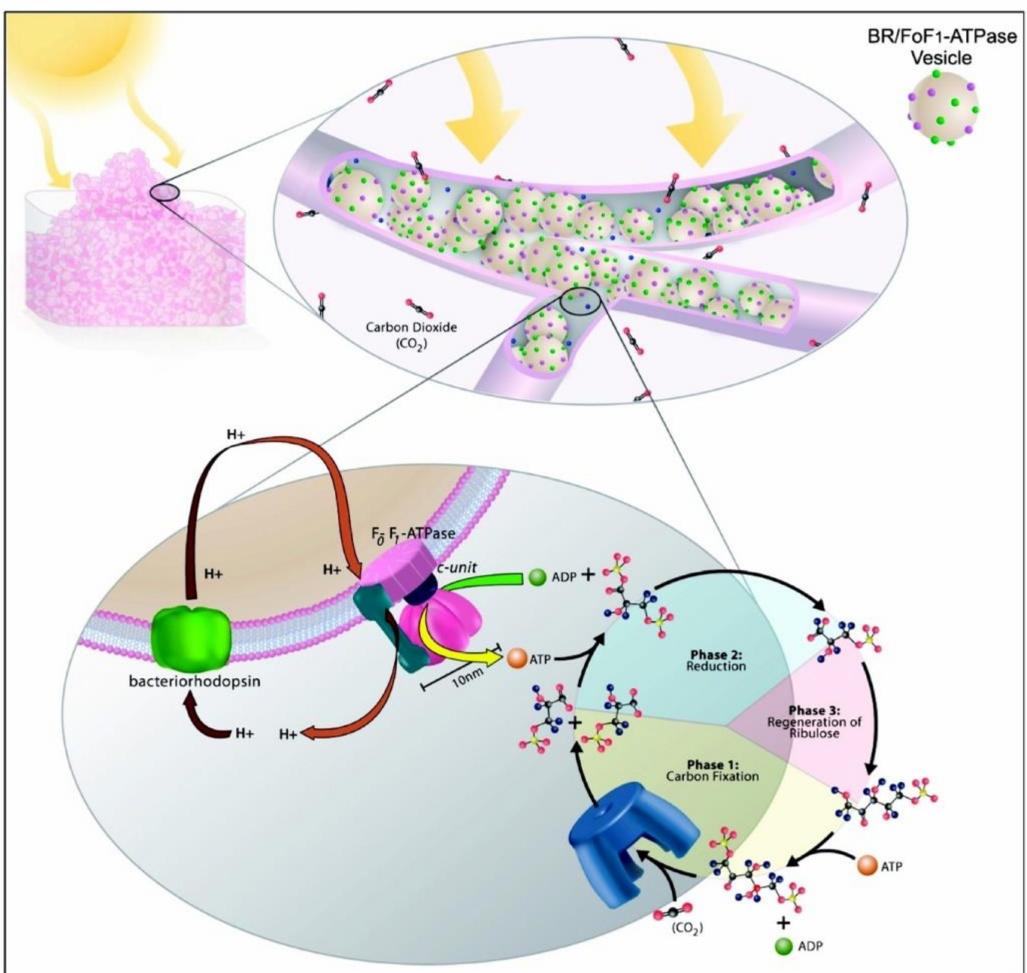
Figure 13. A foam-based artificial photosynthetic system. BR/F 0 F 1 ATP synthase was